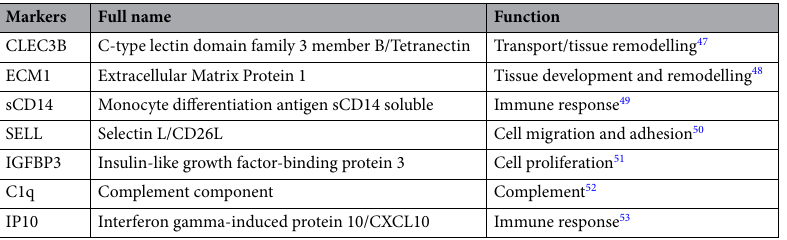
Table 3. List of host markers evaluated in this